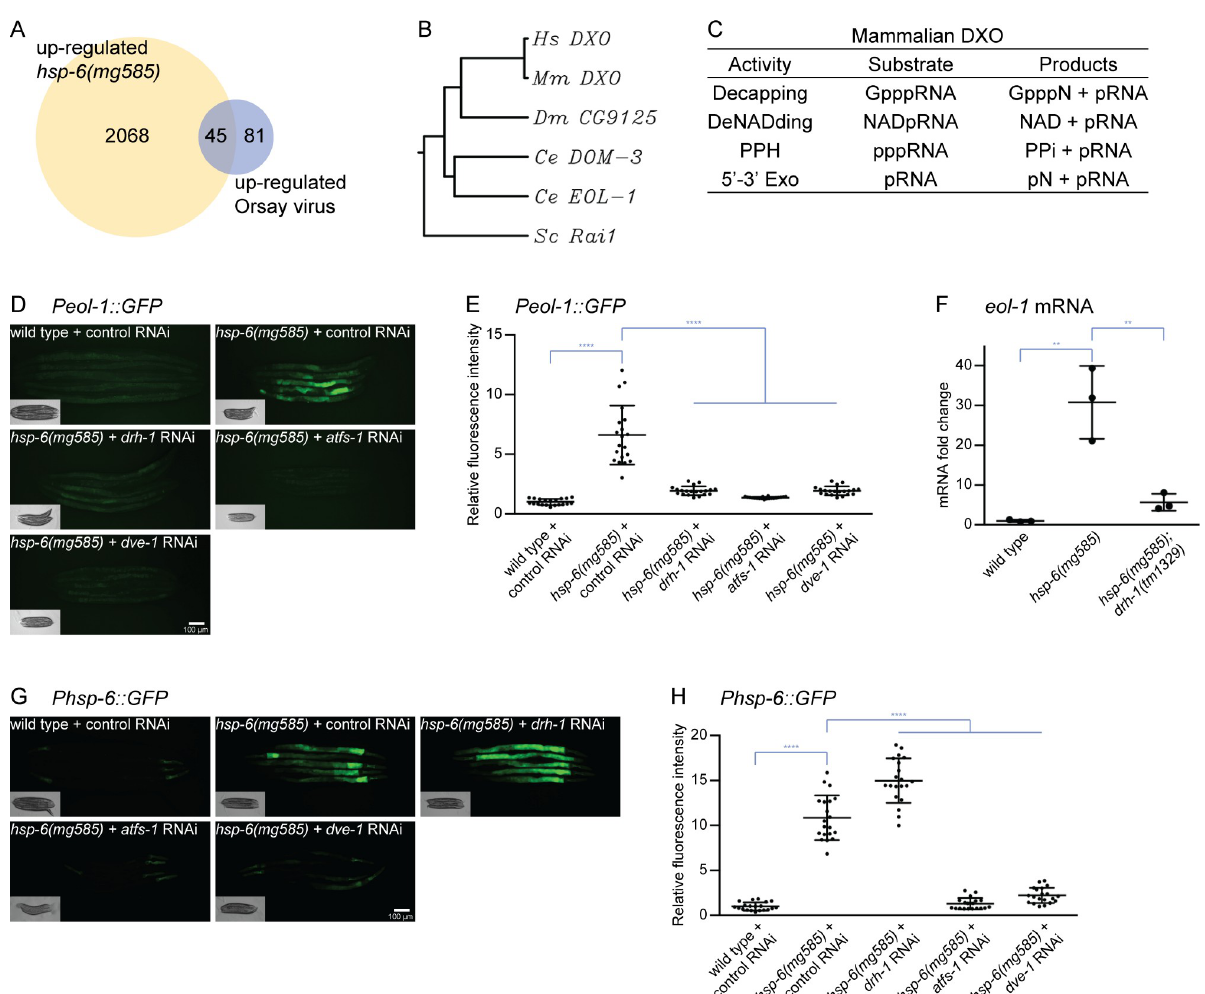
Fig 2. Increased eol-1 expression depends on DRH-1. (A) Venn diagram of genes up-regulated in hsp-6(mg585) and Orsay virus infection. (B) Phylogenetic tree of EOL-1/DXO. EOL-1 is conserved from yeast to mammals. (C) The enzyme activities of human DXO. Mammalian DXO modifies the 5 0 end of mRNAs: decapping, deNADing, pyrophosphohydrolase and 5 0 -3 0 exonuclease. (D and E) The induction of Peol-1 :: GFP transcriptional fusion reporter requires drh-1 and UPR mt . The Peol-1 :: GFP is strongly induced by hsp-6(mg585) mitochondrial mutant, and this induction is abrogated by drh-1 RNAi as well as RNAi of genes involved in UPR mt ( atfs-1 and dve-1 ). Animals were imaged in (D) and the fluorescence was quantified in (E). ���� denotes p < 0.0001. (F) The hsp-6(mg585) mutant causes increased mRNA level of eol-1 in a drh-1 -dependent manner. RT- qPCR assays showed the mRNA level of eol-1 was induced by hsp-6(mg585) mutant, and this induction was abolished in hsp-6(mg585) ; drh-1(tm1329) double mutant. �� denotes p < 0.01. (G and H) DRH-1 does not contribute to UPR mt . The benchmark reporter of UPR mt Phsp-6 :: GFP is induced by the hsp-6(mg585) mutant. And the induction is suppressed by RNAi of atfs-1 or dev-1 , but not drh-1 . Animals were imaged in (G) and the fluorescence was quantified in (H). ���� denotes p < 0.0001. The underlying numerical data can be found in S1 data. Ce : Caenorhabditis elegans ; Dm : Drosophila melanogaster ; Hs : Homo sapiens; Mm : Mus musculus ; RT-qPCR, quantitative reverse transcription PCR; Sc : Saccharomyces cerevisiae . UPR mt , mitochondrial unfolded protein